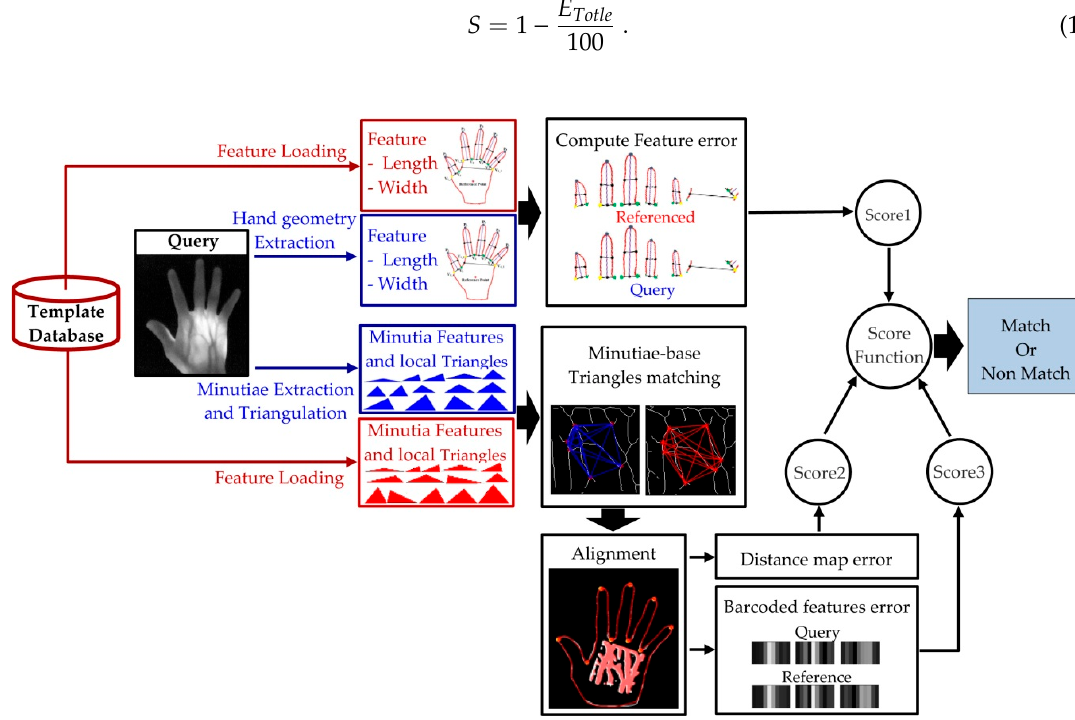
Figure 22. Vein pattern human recognition/verification process.